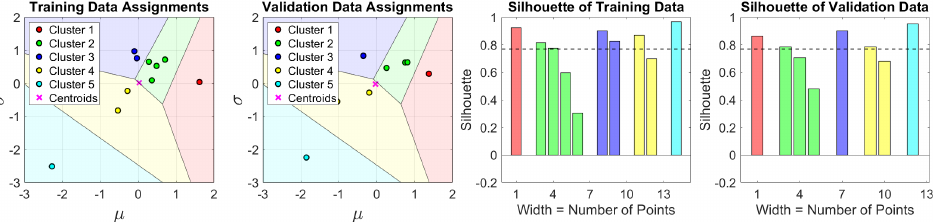
Figure 5. The split result of our proposal. The dotted lines in the right two plots show the average silhouette values for the corresponding left two